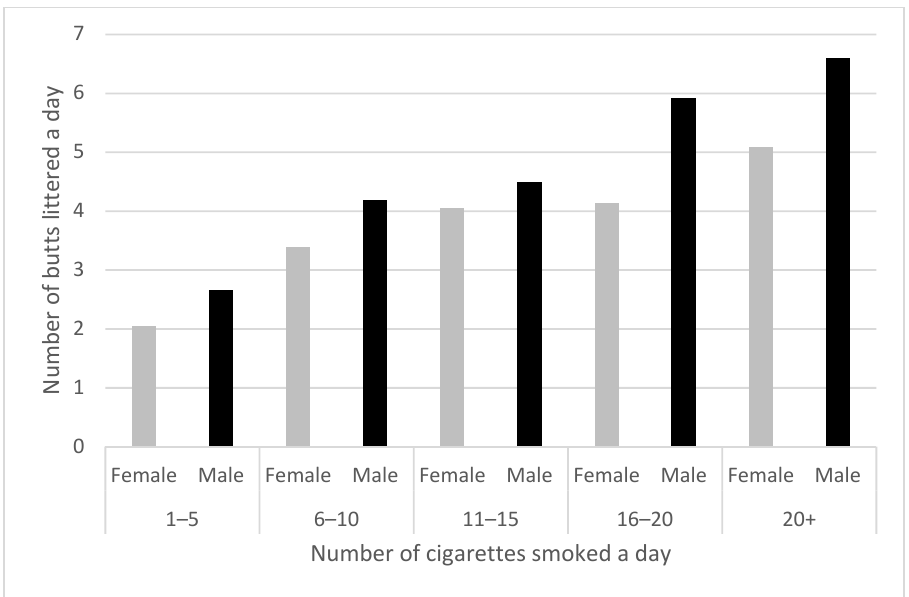
Figure 5. Average number of cigarette butts improperly disposed of by women and men according to number of cigarettes smoked each day ( n = 7453).